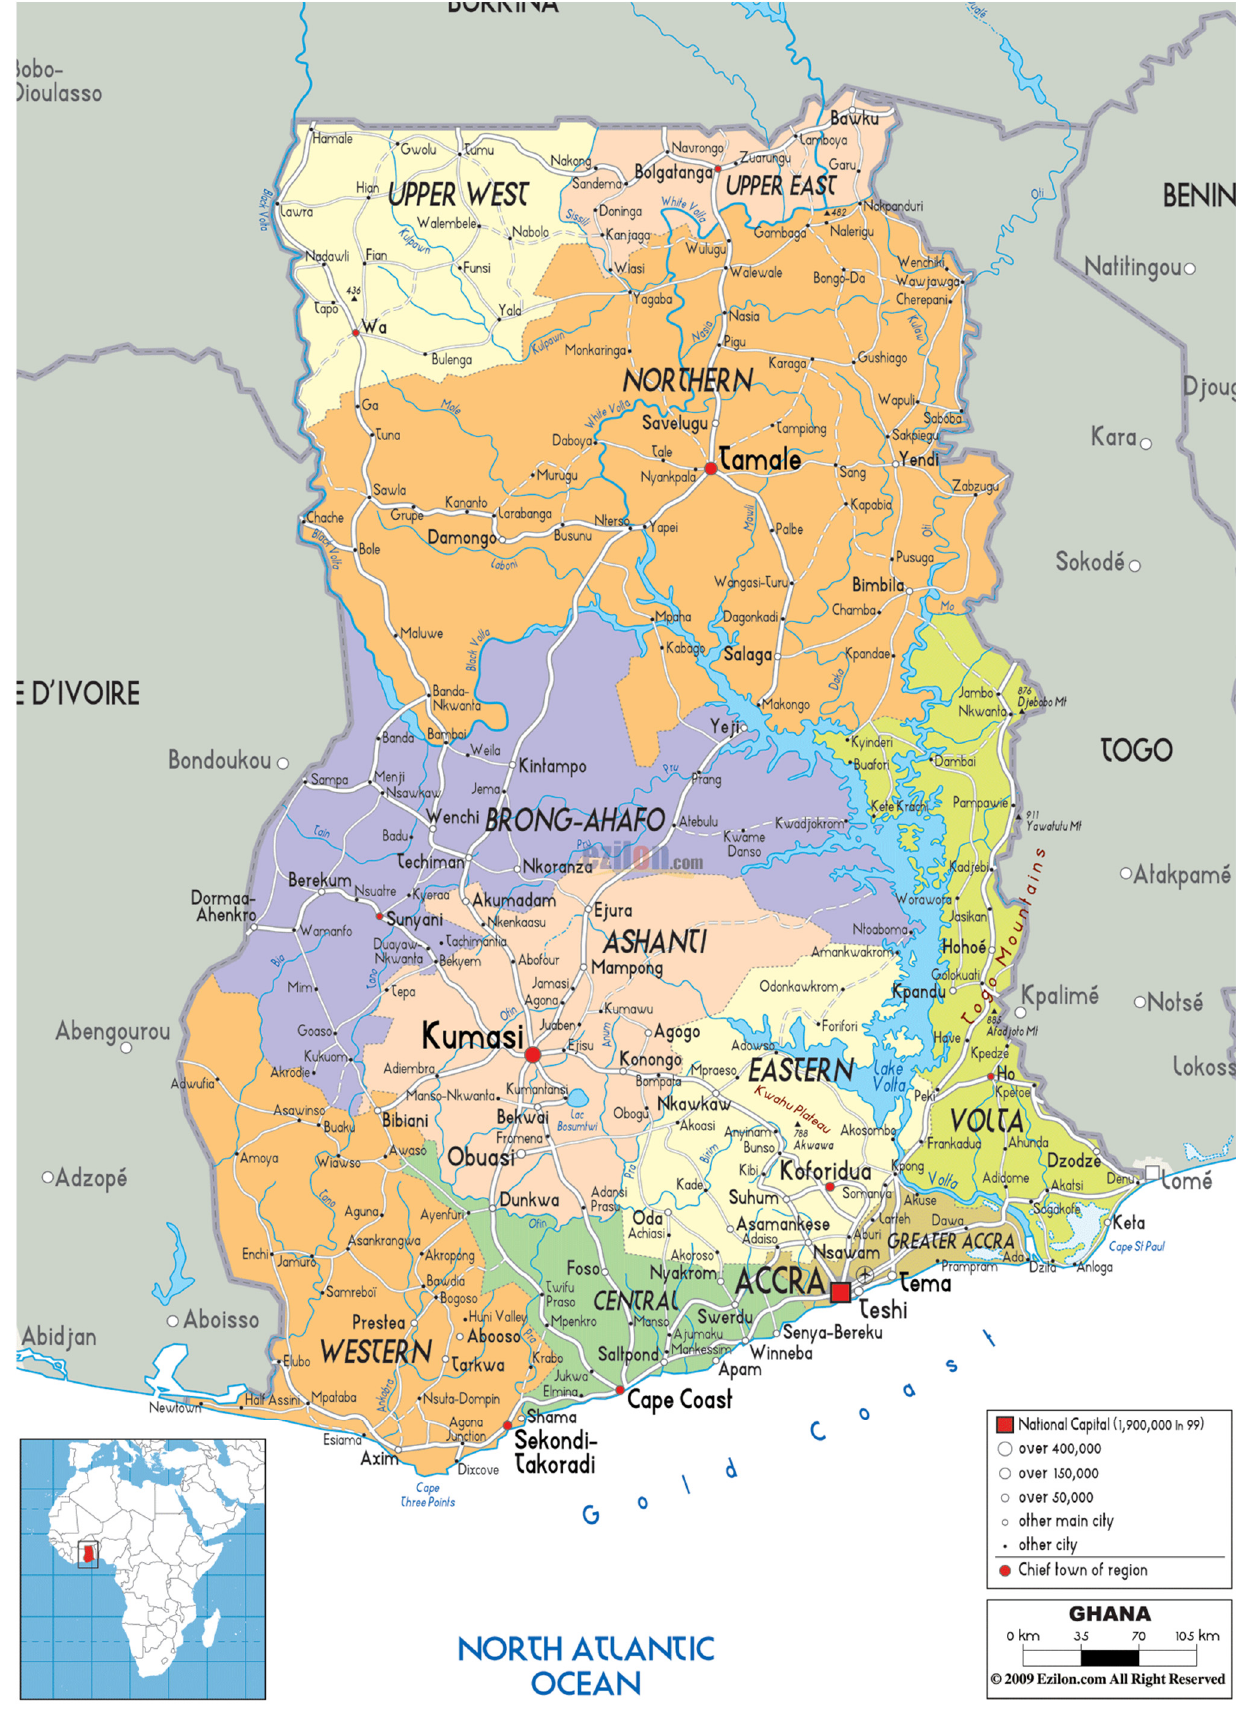
Figure 1. Regional map of Ghana. Source: Ezilon, 2009